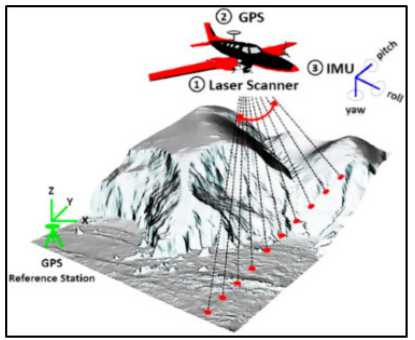
Figure 2. The concept of ALS in collecting data